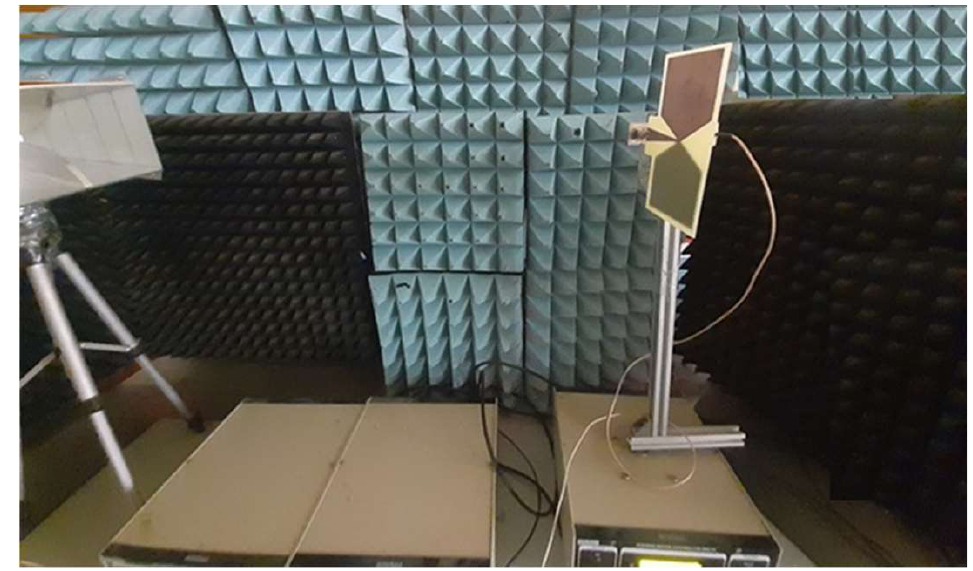
Figure 18. Radiation pattern measurements setup inside the anechoic chamber.